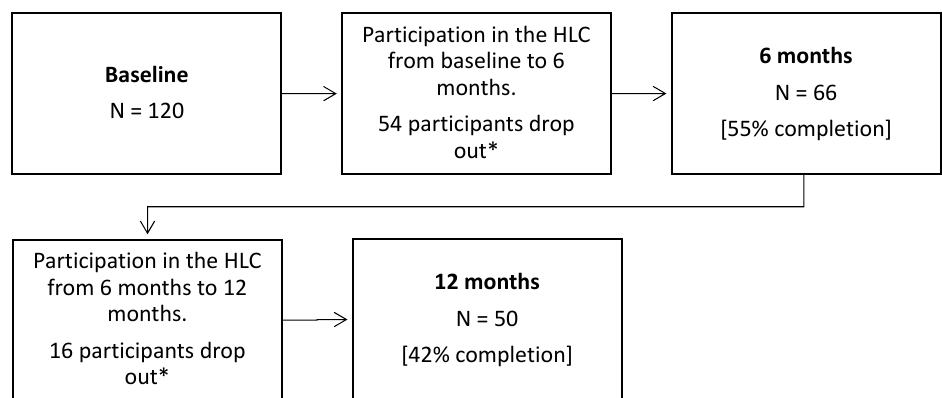
Figure 1. Flow chart of participation in the study from baseline to 12 months. * A majority of the participants who dropped out did so without giving notice or reason, and they did not respond to contact attempts from the HLC. Reasons for dropout included injury, sickness, not finding the activities relevant, lack of time, and pregnancy.